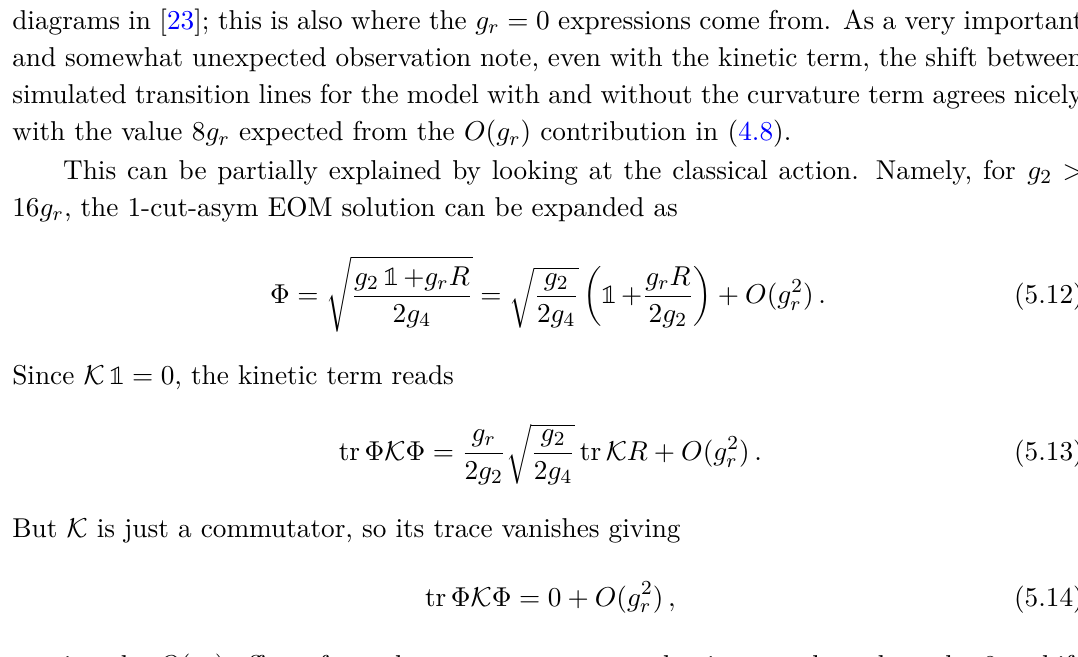
strong-interaction